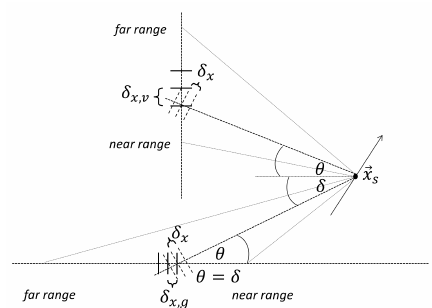
Figure 2. Comparison of down looking and upward looking stripmap SAR geometry with respect to projected resolution. The focusing geometry is rotated by 90 ◦ . of the trajectory can be selected to (cid:126)r 0 = (cid:126) 0 ± (cid:126)n · r c depending on which side (left or right) the sensor